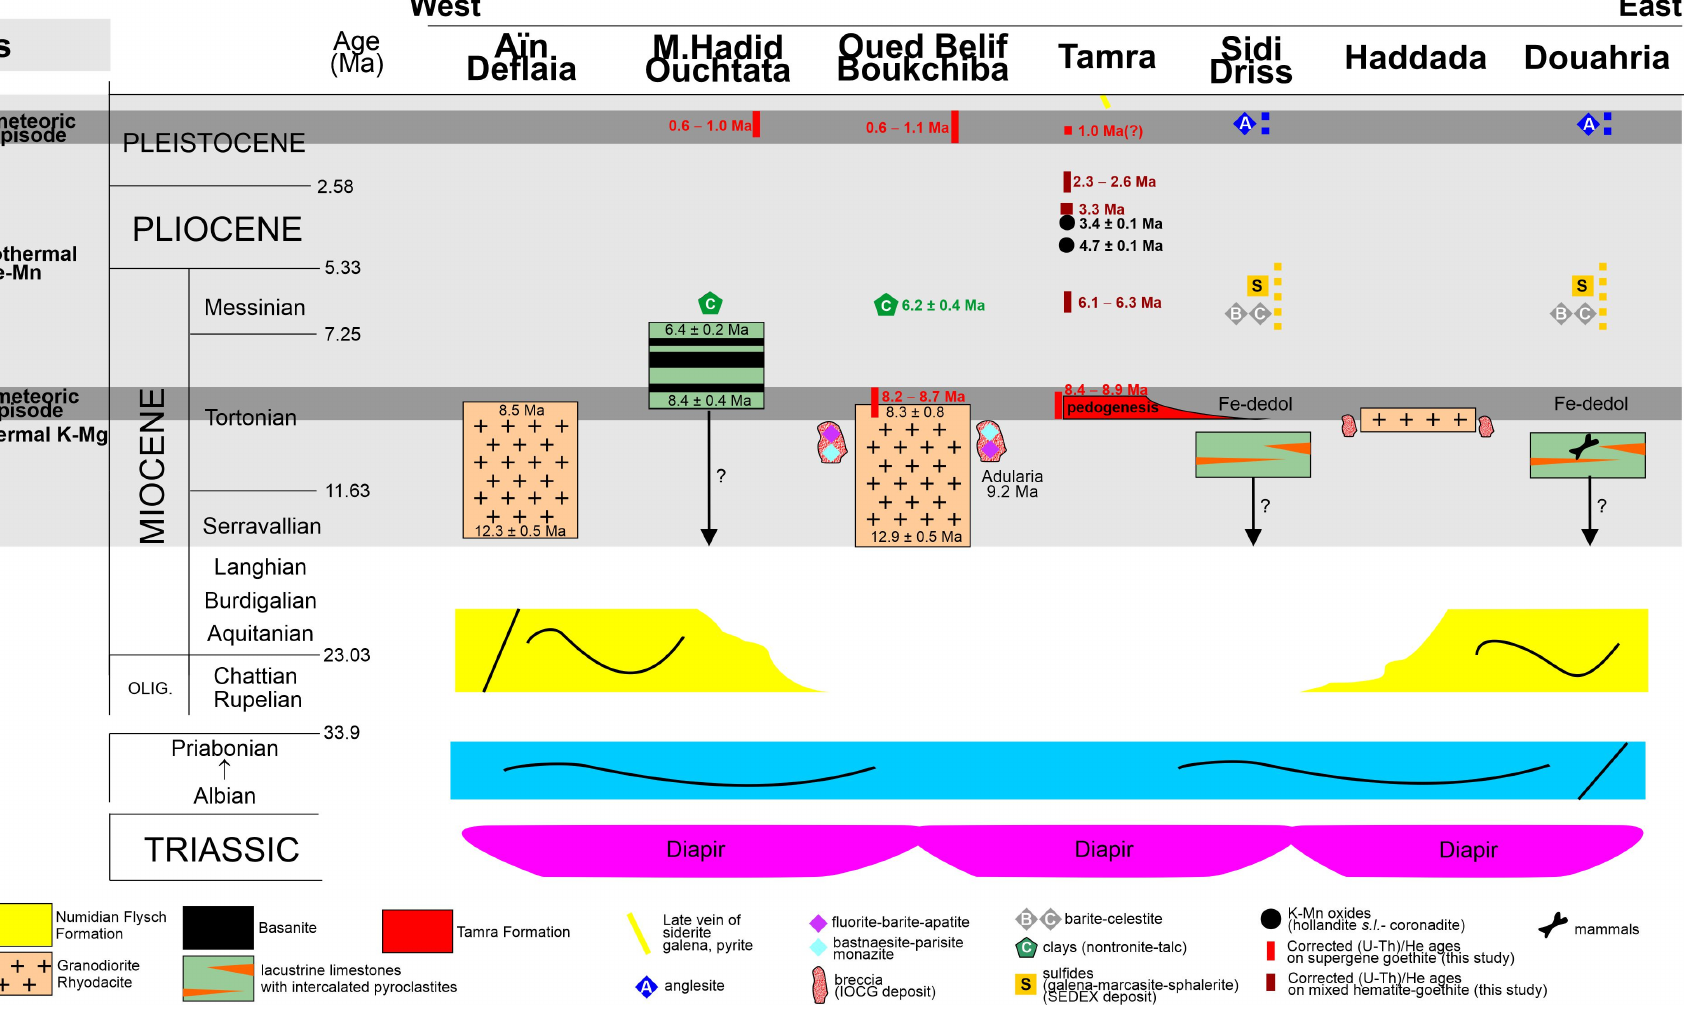
Figure 5. Stratigraphic frame of the Nefza-Sejnane district (Tunisia), including the new (U-Th)/He data on Fe (oxyhydr-)oxides. In red: data on supergene goethite; in red purple: data on mixed hydrothermal-meteoric hematite-goethite. Olig. = Oligocene. Questions marks (?) refer to potential larger stratigraphic extension.